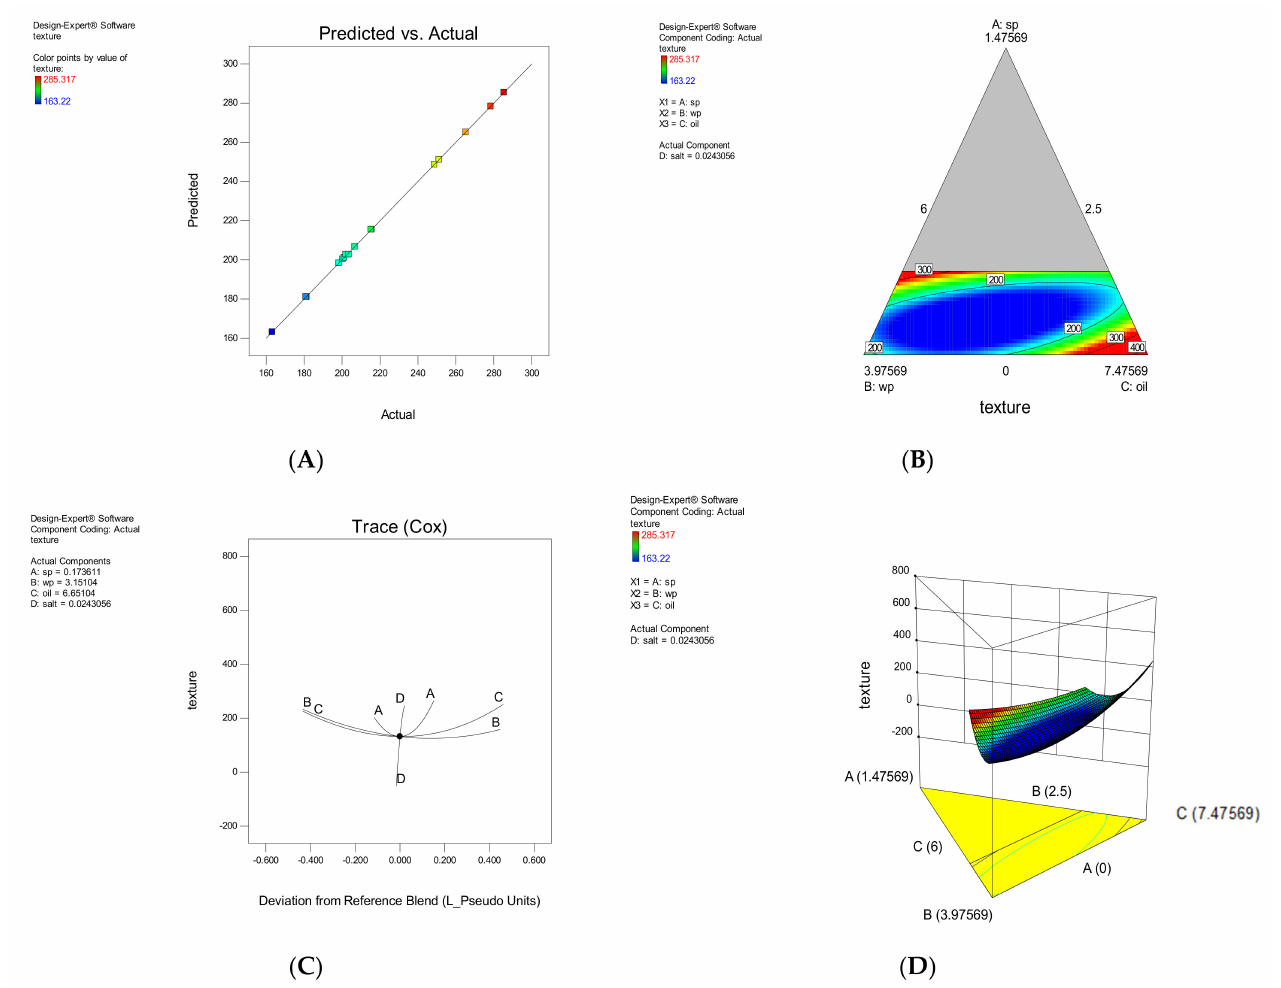
Figure 4. The effect of each parameter on texture (TX). The correlation between experimental and approximated values ( A ), Contour plot ( B ), Trace plot ( C ), three-dimensional response surface plot ( D